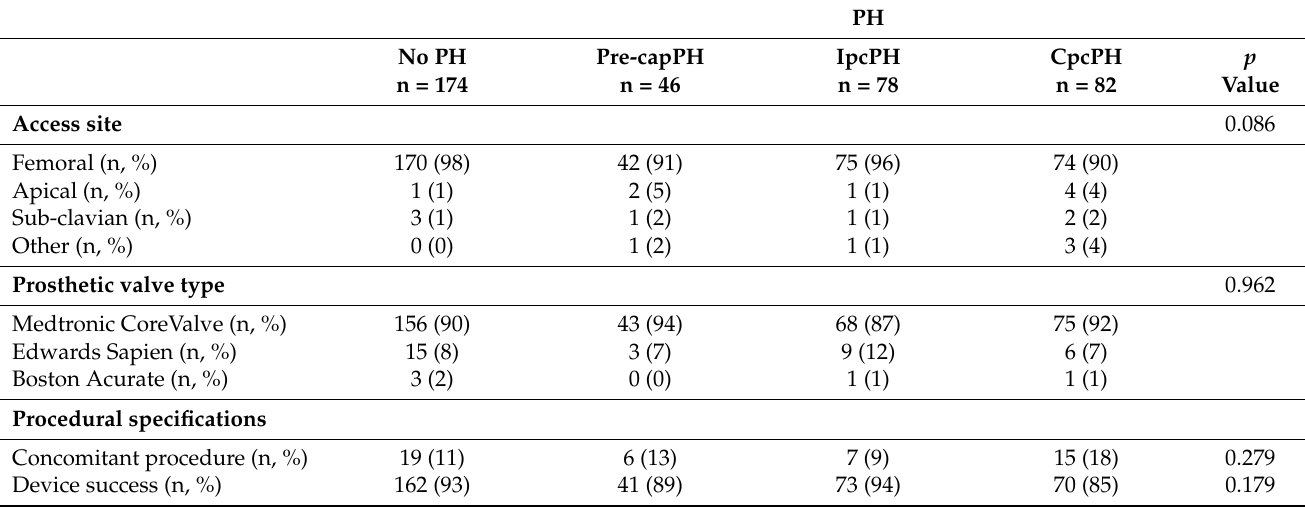
Table 5. TAVR procedural